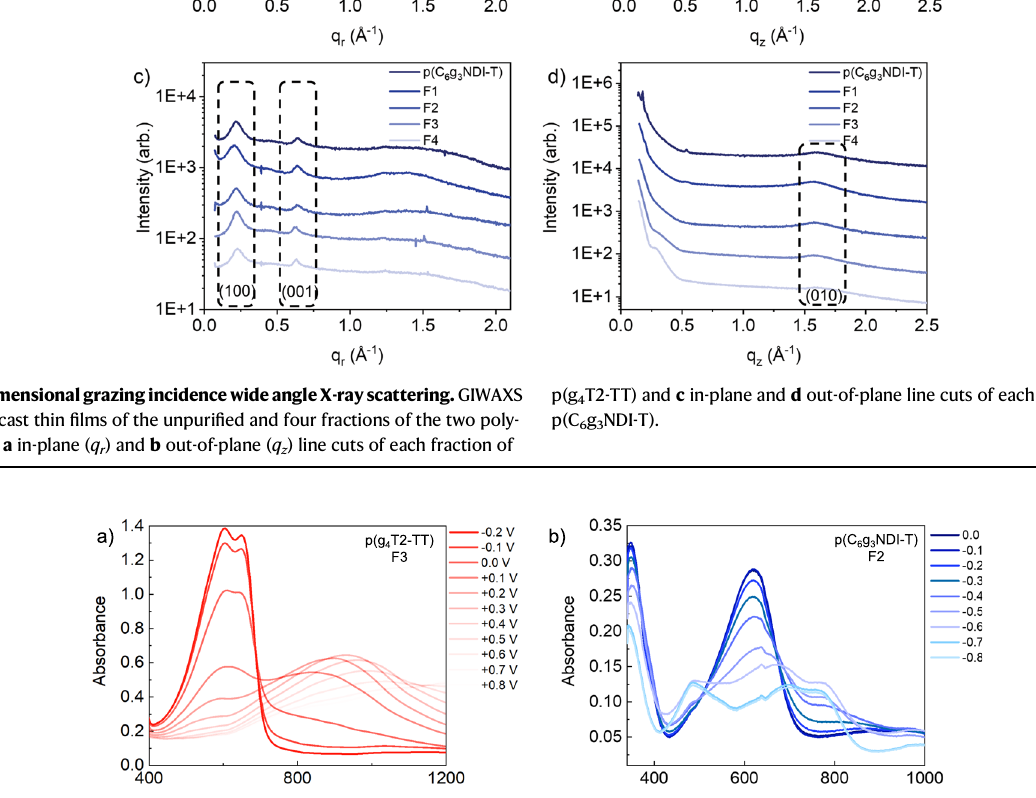
withpotentialsteps of 0.1V. a Fraction 3of p(g 4 T2-TT) between − 0.2and +0.8V vs Ag/AgCland b fraction2ofp(C 6 g 3 NDI-T)between0and − 0.8V.Theunpuri fi edand other fractions for each polymer are shown in Supplementary Fig.